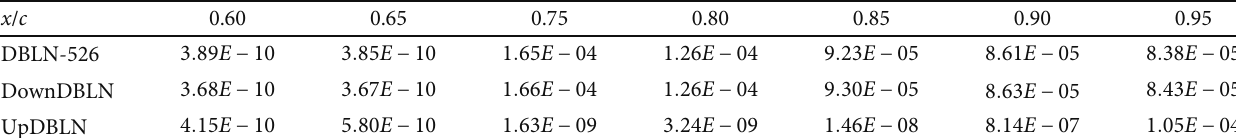
Re = 0 : 8 × 10 6 and α = 0 ° ). ave (